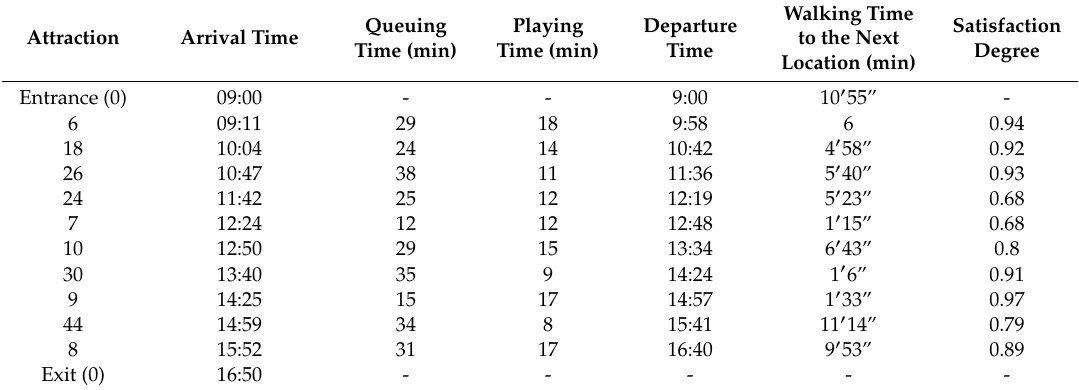
Table 9. Results of the satisfaction route with APGA (60 attractions)